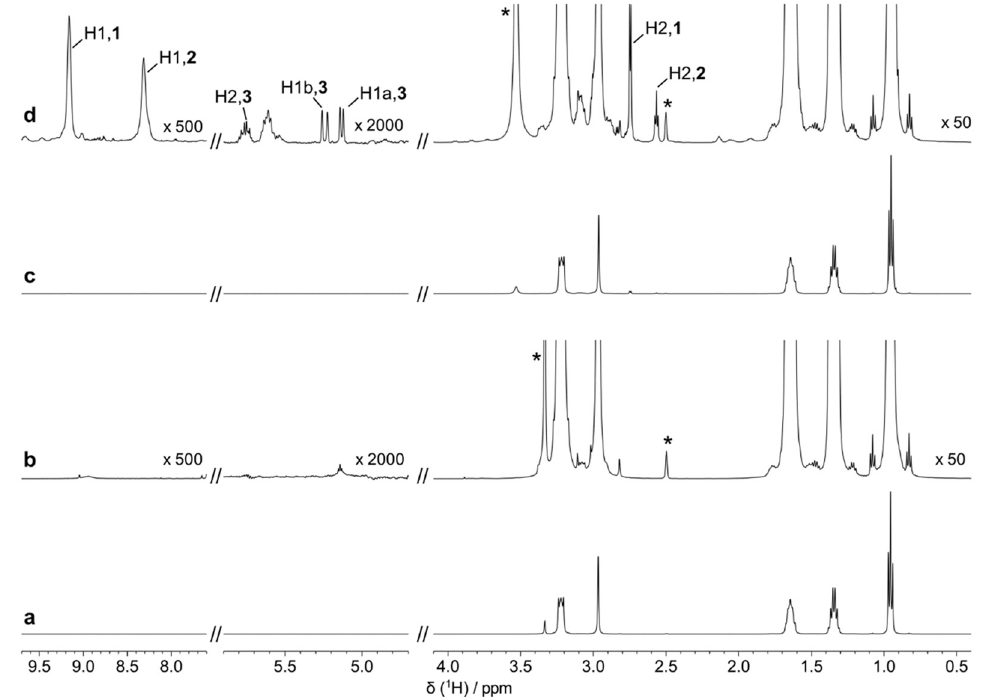
Figure 5. 1 H HRMAS NMR spectra of [TBuMA][NTF 2 ] ( a , b ) and 4B168 ( c , d ); in ( b , d ), the vertical scale used in ( a , c ) is expanded by the factors reported on each spectral region. Selected signals of the degradation compounds are labeled as “Hi,j”, with i representing the atom number and j indicating the degradation product (Scheme 1). Signals of water protons and residual protons of deuterated DMSO are marked with asterisks.